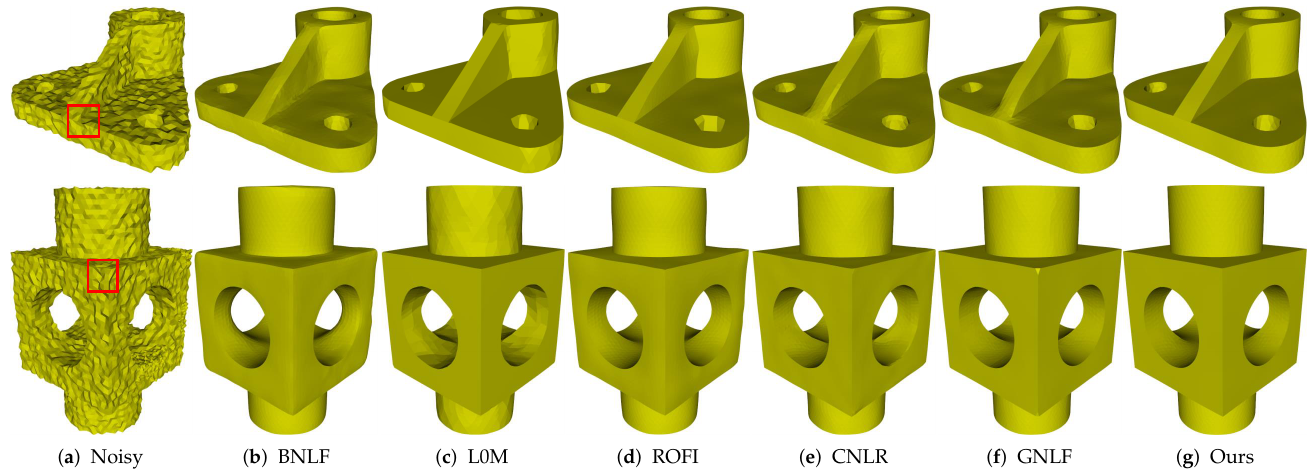
Figure 4. Denoising results of Part and Block models.